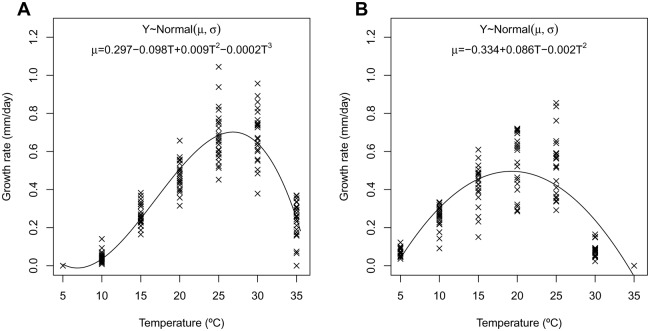
Responses to temperature (T) of radial mycelial growth rate (Y) denoted by a normal distribution of mean μ and standard deviation σ.A, Zasmidium citri-griseum complex isolates (n = 25). B, Amycosphaerella africana (n = 21).